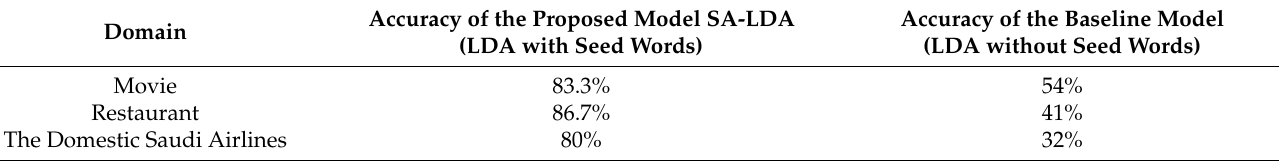
Table 5. Performance evaluation of reviews using SVM and comparison of related work